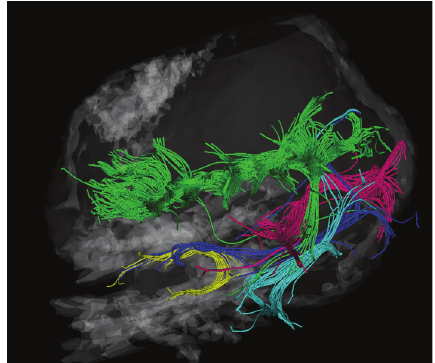
Figure 4: Spatial relation of the pyramidal tract (red), the medial lemniscus (blue), and the uncinate fasciculus (yellow).